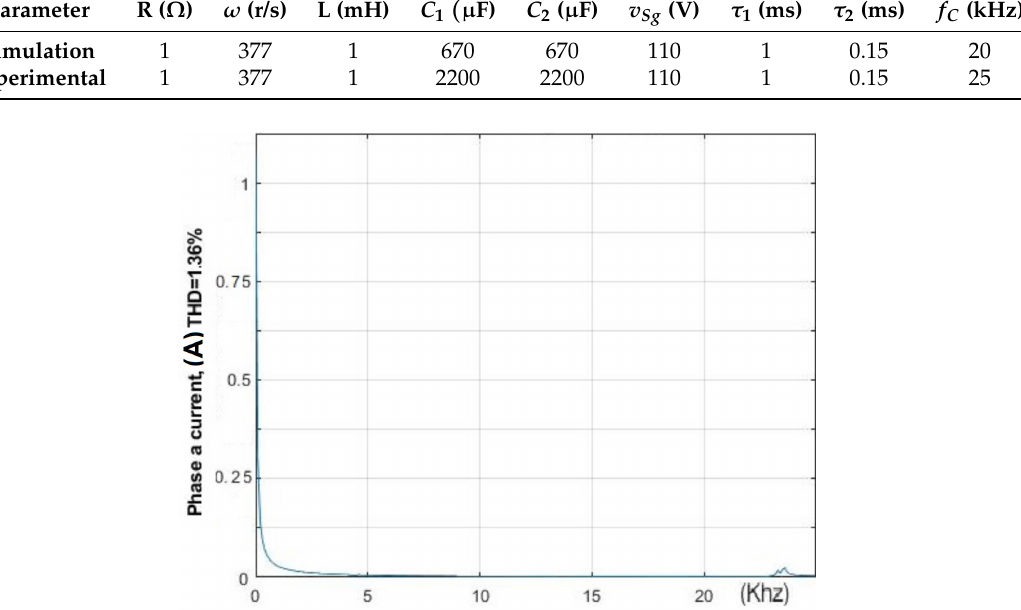
Figure 17. Harmonic spectrum. Phase a current, at no = load. f C = 24 kHz. THD =